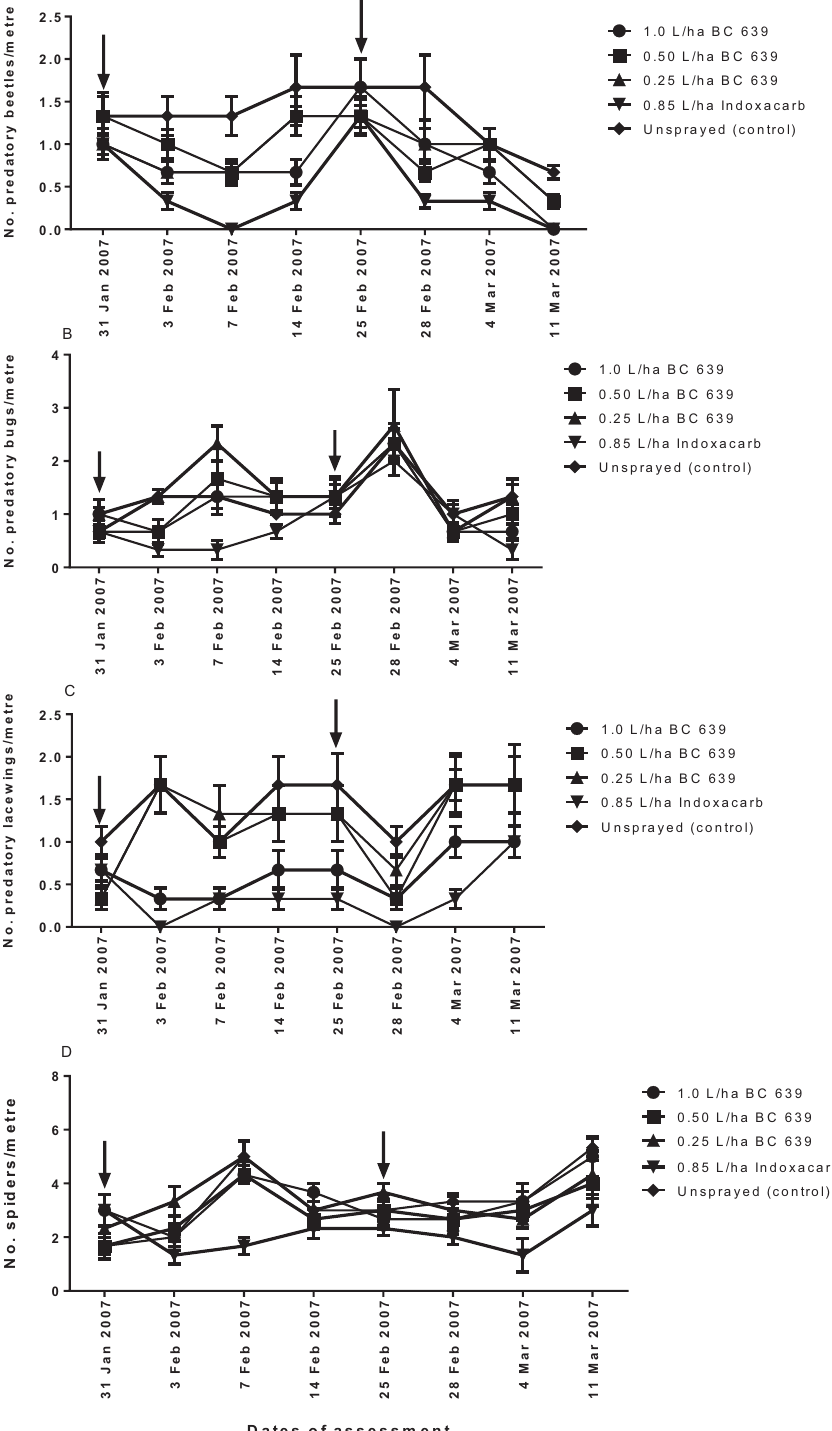
Figure 3. Efficacy of different rates of application of BC 639 and synthetic insecticide (Indoxacarb) on the number of ( A ) predatory beetles, ( B ) predatory bugs, ( C ) predatory lacewings and ( D ) spiders on commercial conventional cotton crops at Getta Getta near Goondiwindi, 2006 – 2007. The arrows indicate the date of